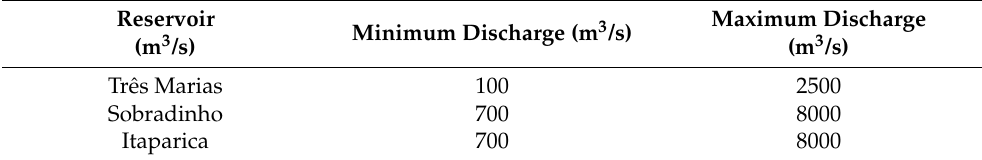
Table 3. Operational restrictions downstream studied reservoirs.